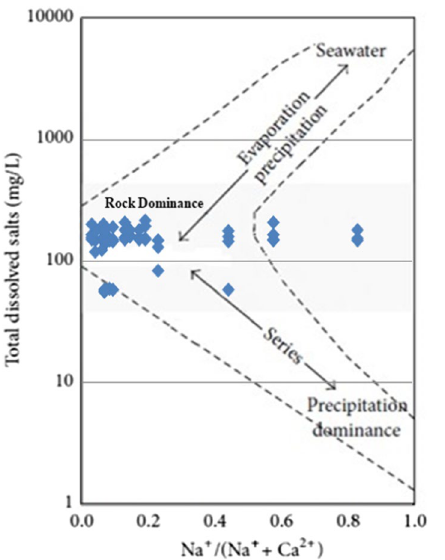
Fig. 5 Gibbs diagram representing the geochemical processes con- trolling irrigation water chemistry of high altitude (Leh, Ladakh,